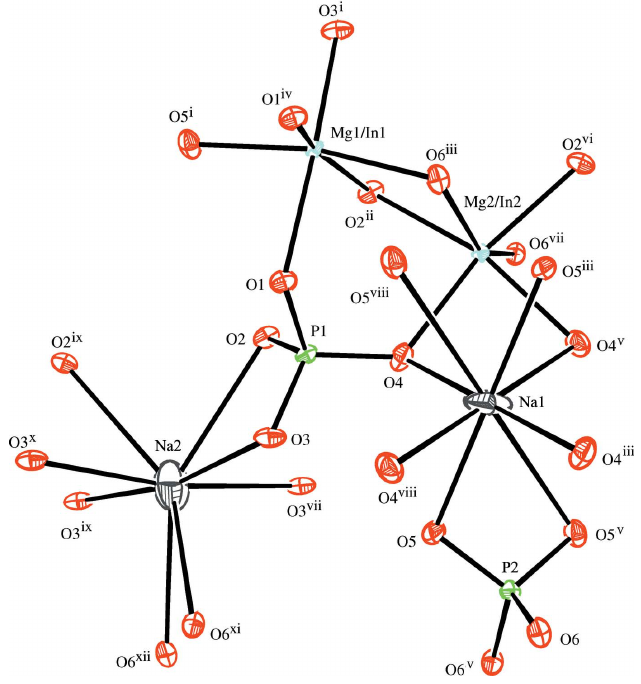
Figure 1 The principal building units in the structure of Na 1.85 Mg 1.85 In 1.15 (PO 4 ) 3 , (I). Displacement ellipsoids are drawn at the 50% probability level. [Symmetry codes: (i) (cid:3) x + 3 (cid:3) x + 1, (cid:3) y + 1, (cid:3) z ; (iv) (cid:3) x + 3